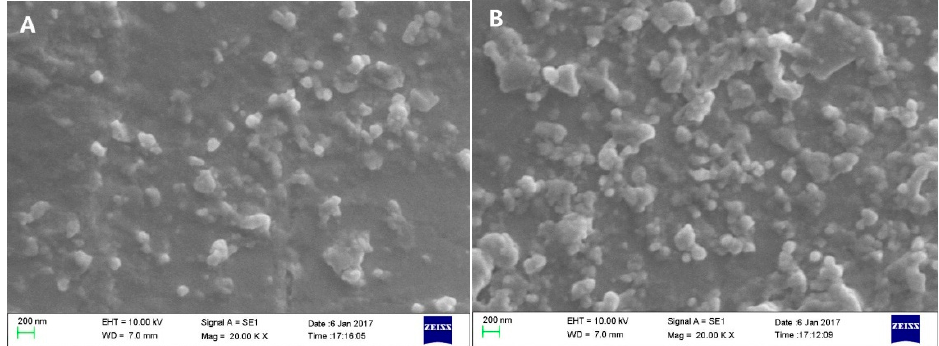
Figure 1. SEM images of GA liposomes (GA-Lp) ( A ) and liposomes containing mannose-diester lauric